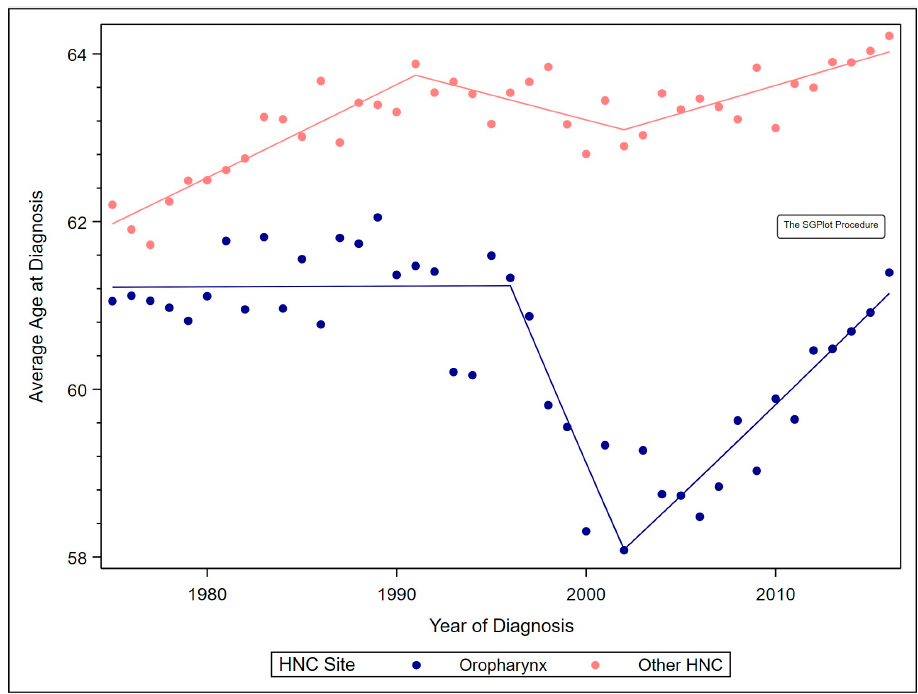
Figure 1. Observed average age at diagnosis by year and Joinpoint regression models by site.